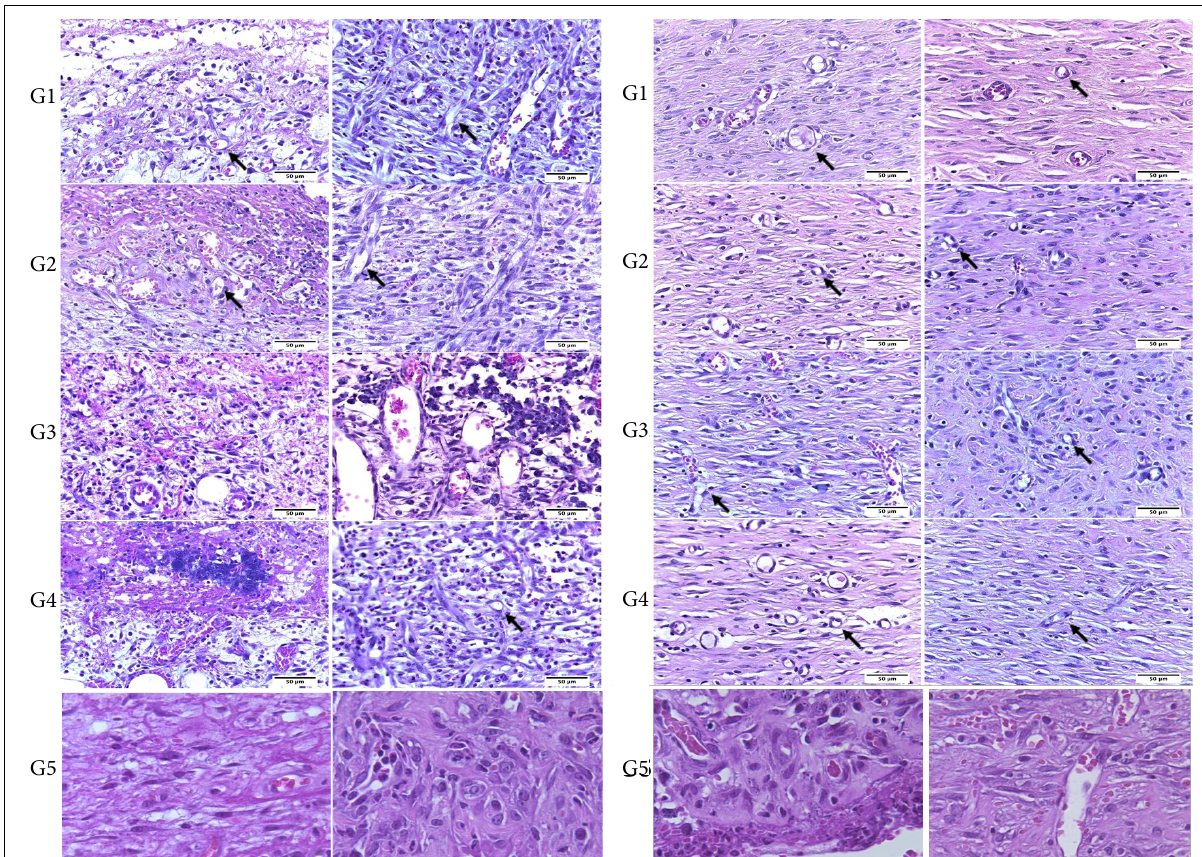
Figure 3 - Photomicrograph of the skin of rats which suffered the experimental induction of an excisional wound at three, seven, 14 and 21 DAI. Stain: hematoxylin and eosin. Scale: 50 μ m. Arrows indicate the presence of new vessels